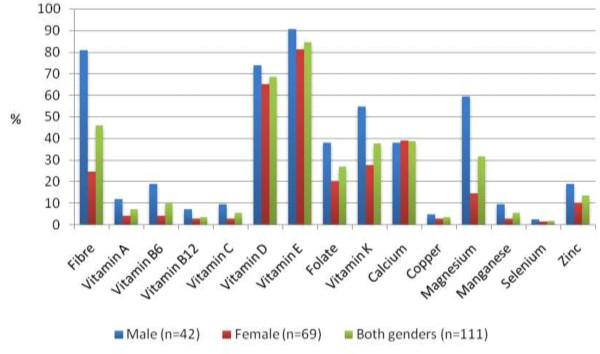
Estimated overall and gender specific prevalence of micronutrient intake inadequacy among senior residents from Newfoundland and Labrador.